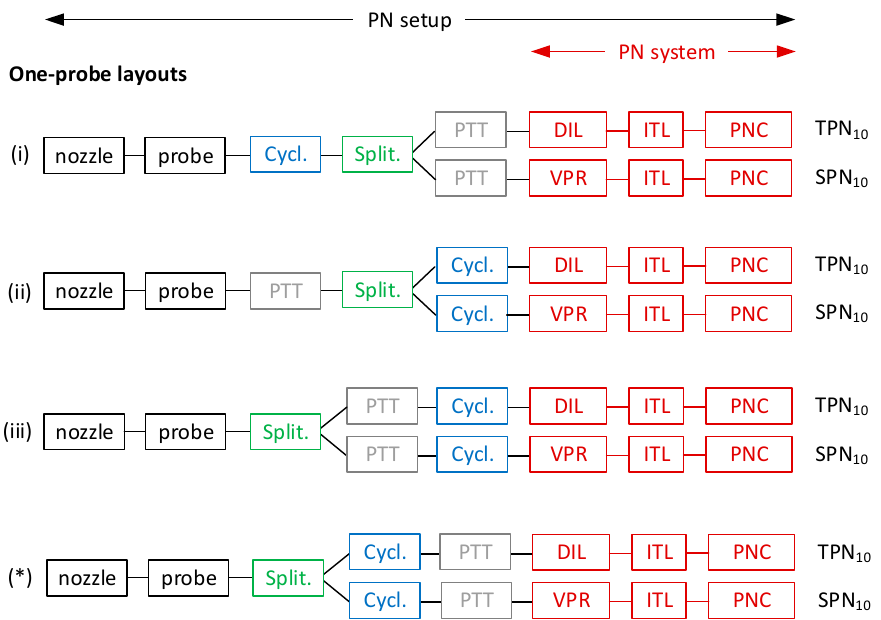
Figure A1. Particle number (PN) setup parts and layouts using one-probe. PN system in red (three last parts). The asterisk (*) indicates a one-probe configuration not allowed in the current GTR version. Cycl. = cyclonic separator; DIL = diluter; ITL = internal transfer line; PNC = particle number counter; PTT = particle transfer tube; Split. = flow-splitting device; VPR = volatile particle remover.